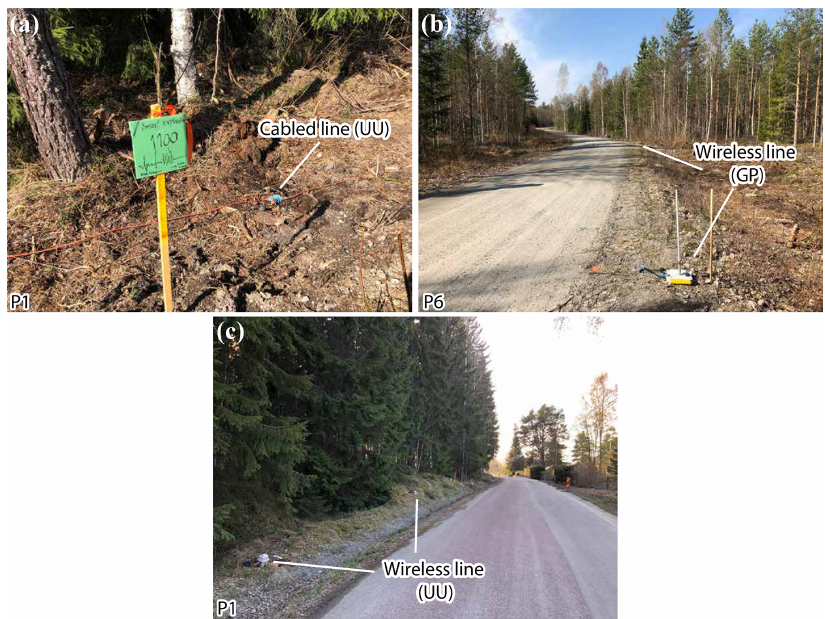
Figure 4. Field photos showing different seismic recorders used during the 3D survey. (a, c) With the exception of P1 and P3, where a Sercel recording system was used (cabled and wireless recorders along P1 and only cabled along P3), (b) all other profiles were acquired using RT2 Wireless Seismic requiring a maximum distance of 50m for data crosstalk and live data harvesting. The choice of the recorders was solely dictated by their availability to the research team. UU stands for Uppsala University, and GP stands for Geopartner. Photos by Alireza